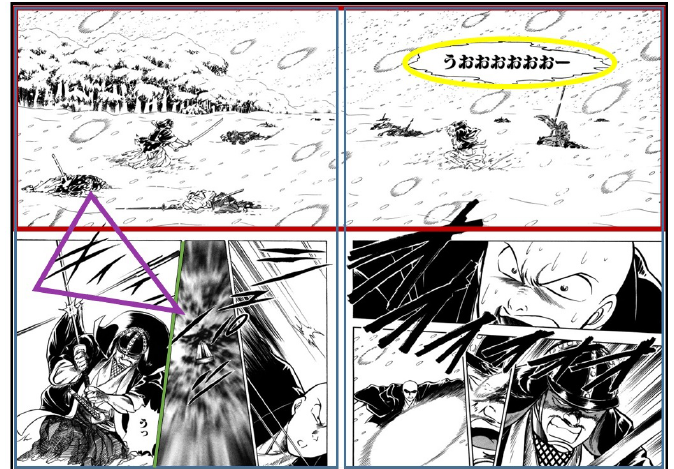
Figure 1. An example of a double comic pages. The largest black rectangle encloses two pages which are represented by blue rectangles. The red rectangles are examples of panel frames. They can be small or large, overlap each other and have different shapes. Some panels do not have frames and some others can be drawn on more than a page. The green lines are examples of gutters, a white area used for separating two panels. The yellow ellipses are examples of dialogue balloons. They can have different shapes to represent the feelings of the speaker. The purple triangles are examples of onomatopoeias; they represent the sound made by people (such as footsteps), objects (water falling, metal blades knocking each other), etc. Source: images extracted from the Manga109 dataset [10], c (cid:13) Sasaki